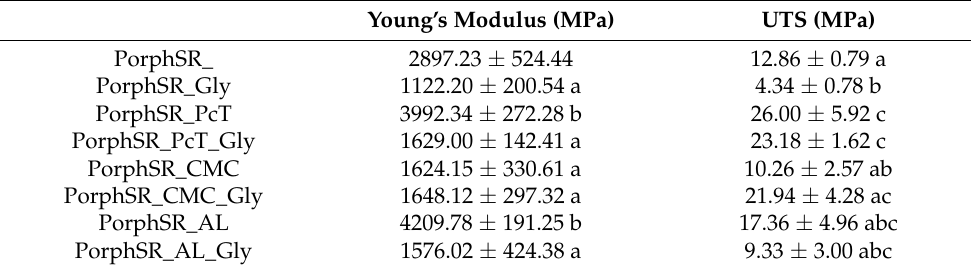
Figure 2. SEM images of the produced films: ( a ) PorphSR, ( b ) PorphSR_Gly, ( c ) PorphSR_CMC, ( d ) PorphSR_CMC_Gly, ( e ) PorphSR_PcT, ( f ) PorphSR_PcT_Gly, ( g ) PorphSR_AL, ( h ) PorphSR_AL_Gly. Table 4. Young’s Modulus and Ultimate Tensile Stress average values obtained for the produced films. Lowercase letters on data symbolize the statistically significant differences with a significance of 5%.